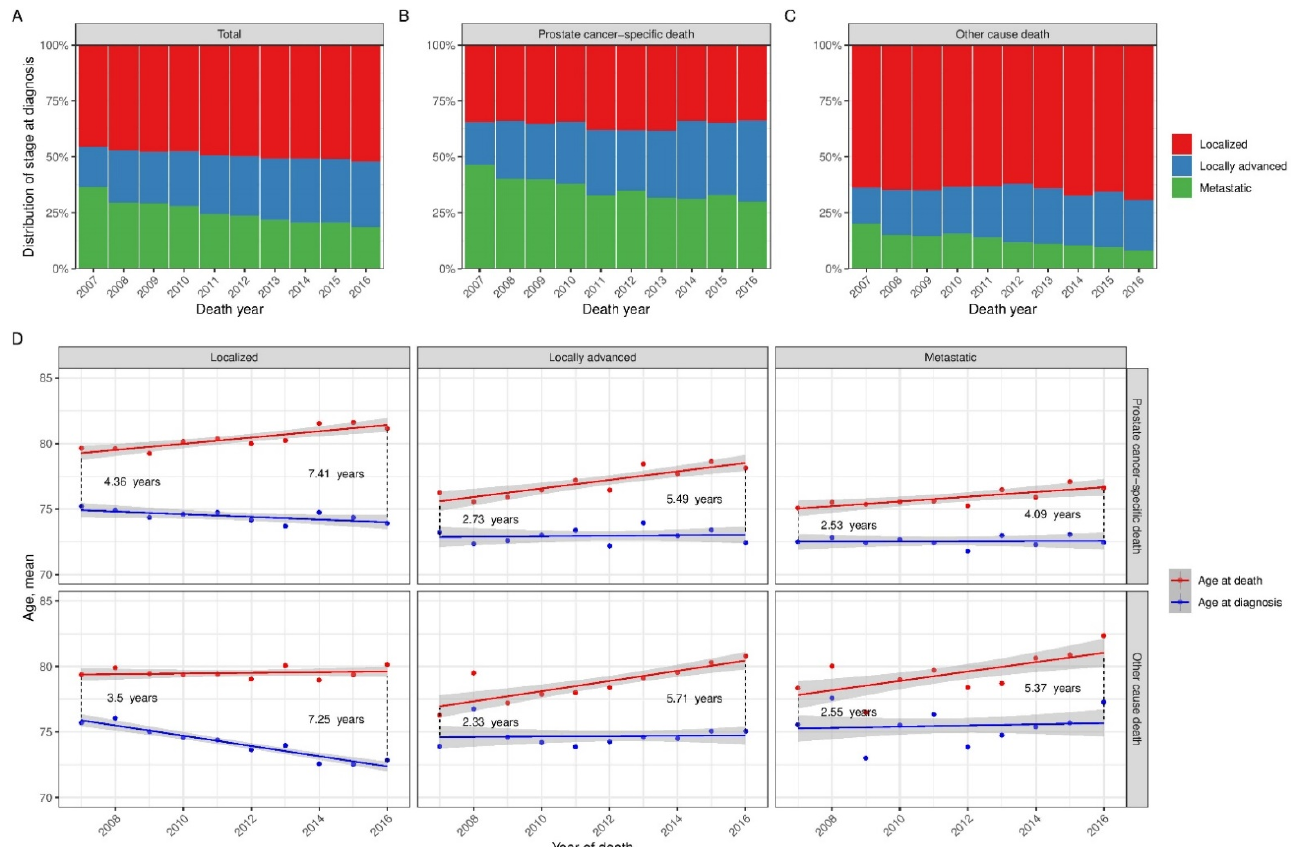
Figure 4. Temporal trends in distribution of stage at diagnosis, age at diagnosis and age at death among dead men with prostate cancer. ( A ) Distribution of stage at diagnosis in total cohort; ( B ) Distribution of stage at diagnosis in men dying of prostate cancer; ( C ) Distribution of stage at diagnosis in men dying of other causes; ( D ) Linear regression of observed age at death and diagnosis with the 95% confidence interval of the regression in grey, and the mean age at diagnosis and mean age at death per year of death stratified by stage at diagnosis and cause of death. Differences in time from diagnosis to death are calculated as the difference in the predicted age from the linear regression models, respectively.